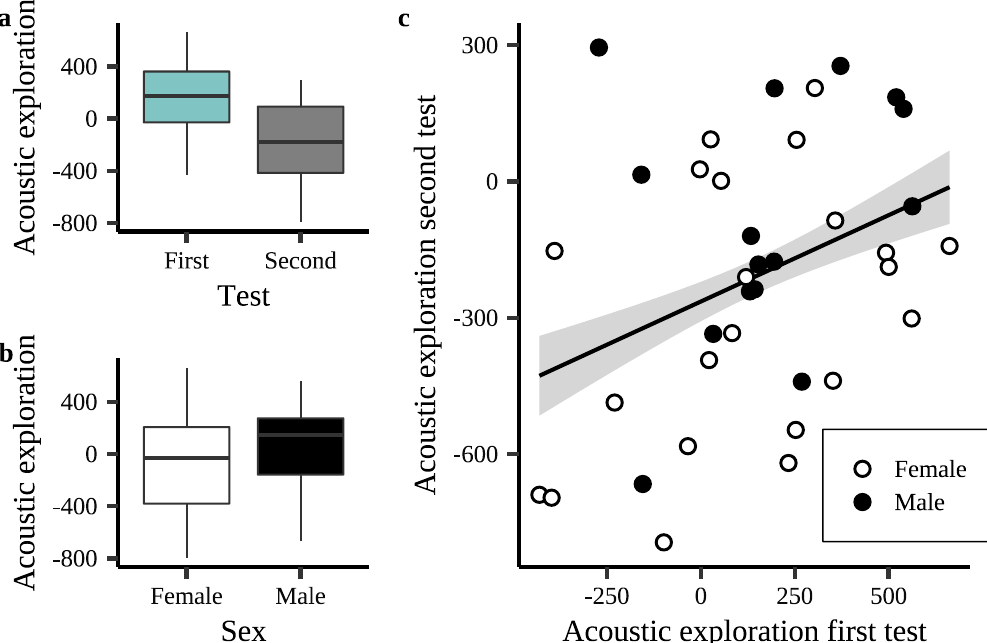
Figure 3. Acoustic exploration, i.e., residuals of the number of echolocation calls as a function of the number of chambers visited, during the first and second novel environment test with Nathusius’ pipistrelles. ( a ) Individuals show more acoustic exploration during the first than the second novel environment test (a maze-like arena). ( b ) Males show more acoustic exploration than females. Males and females are represented by a black or white fill, respectively. ( c ) Acoustic exploration during the first novel environment test predicts an individual’s acoustic exploration during the second test. The regression line in panel ( c ) shows the predicted final model values. Shaded areas around the line reflect the 95% Confidence Interval. Box plots in panels ( a ) and ( b ) show median and interquartile range with whiskers of 1.5 interquartile